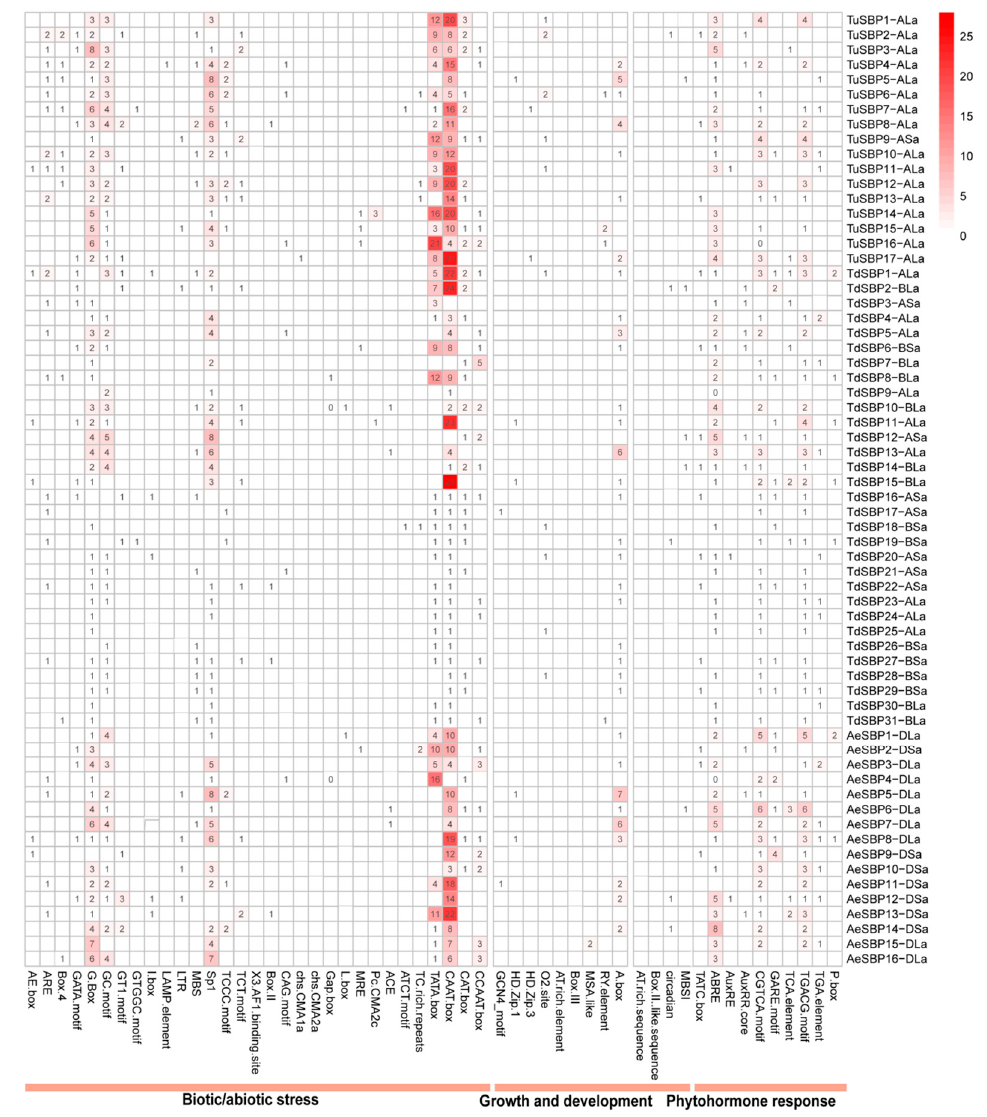
Figure 8. Cis -acting elements in the promoters of SBP genes from Triticum urartu , Triticum dicoccoides and Aegilops tauschii . The different shades of red color represent the number of cis -acting elements.